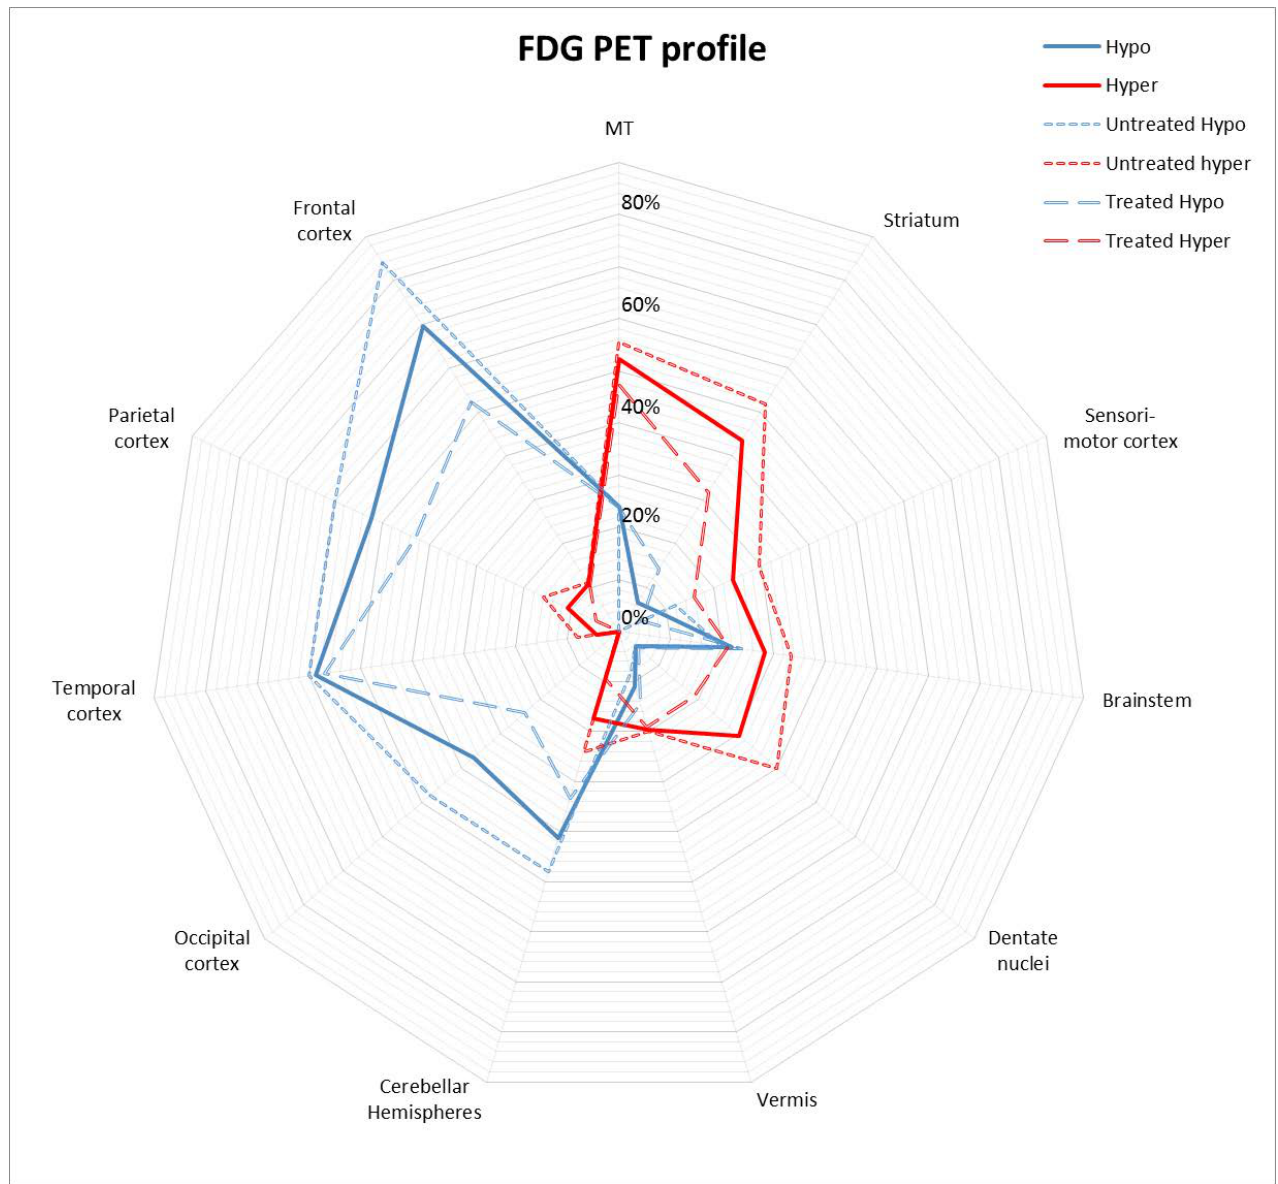
Figure 2. Prevalence of regional metabolic changes on FDG PET (hypermetabolism and hypometabolism) in the whole cohort, in patients treated for less than one month (referred to as untreated) and in those treated for more than one month (referred to as treated). FDG PET: 18 F-fluoro-deoxy-glucose positron emission tomography, MT: medial temporal.